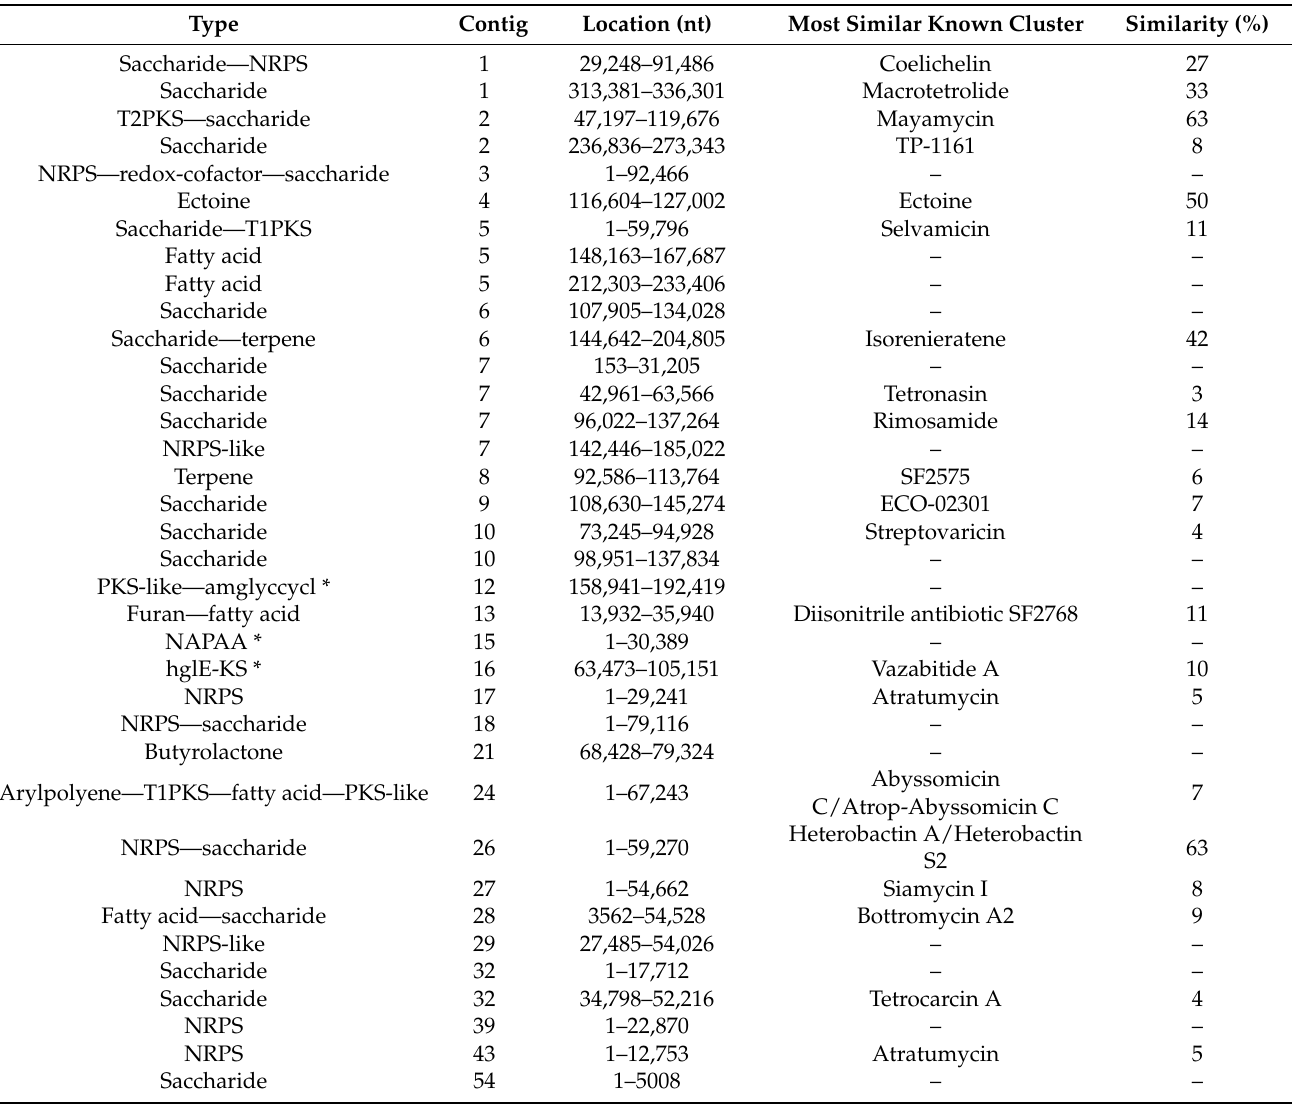
Table 2. antiSMASH identification and analysis of BGCs in Rhodococcus sp. I2R whole genome